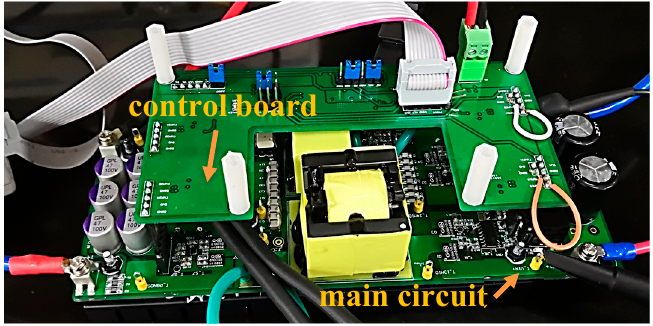
Figure 9. Structure of the prototype. Table 4. Main components of the